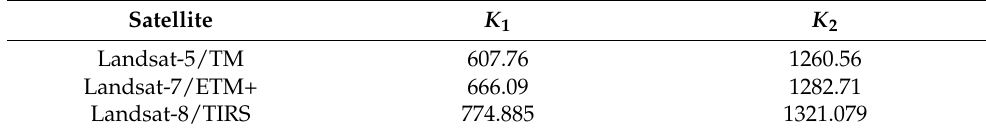
Table 3. K 1 and K 2 conversion constant for each Landsat